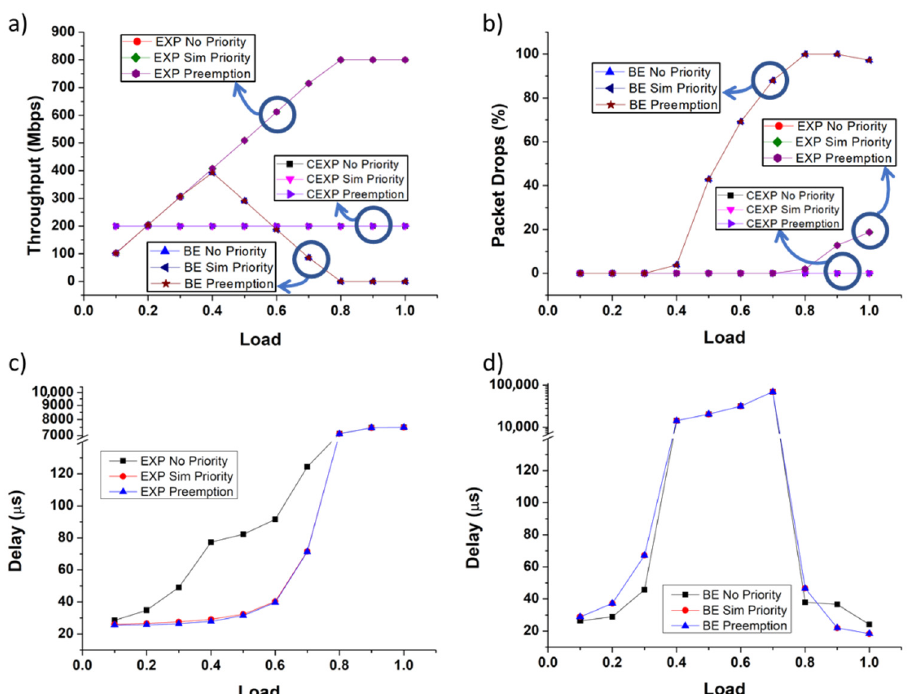
Figure 8. Performance evaluation vs. load for three PS execution policies: No priority, EXP priority and Pre-emption priority: ( a ) Throughput vs. Load, ( b ) Packet drops vs. Load, ( c ) Delay vs. Load for EXP traffic, and ( d ) Delay vs. Load for BE traffic.